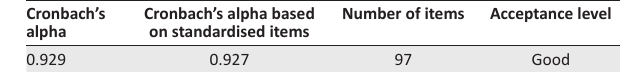
TABLE 1: Reliability analysis. Cronbach’s Cronbach’s alpha based alpha on standardised items